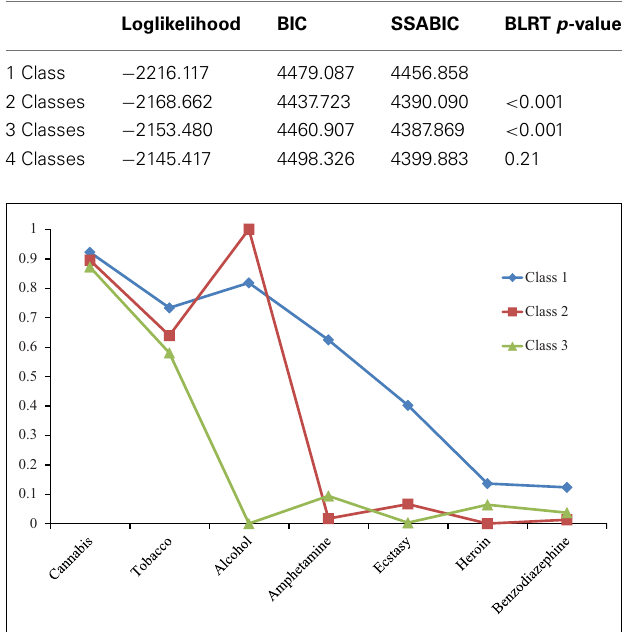
Table 2 | Fit statistics of the unconditional latent class analysis.